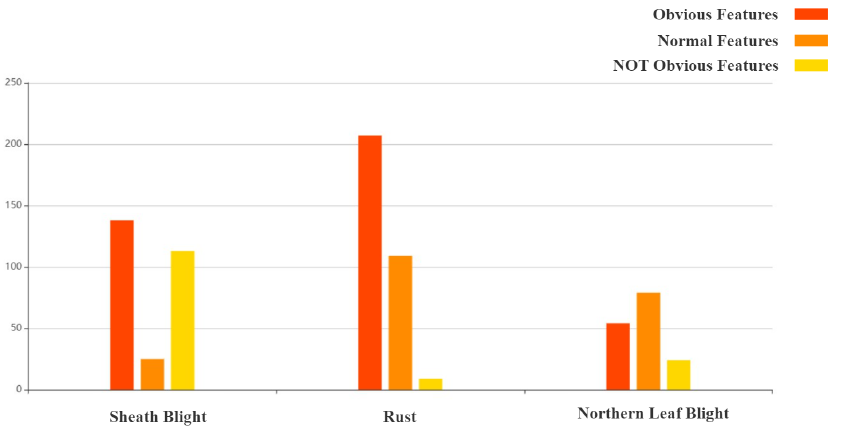
Figure 3. Histogram showing the number of three maize leaf disease images with obvious, normal, and not obvious